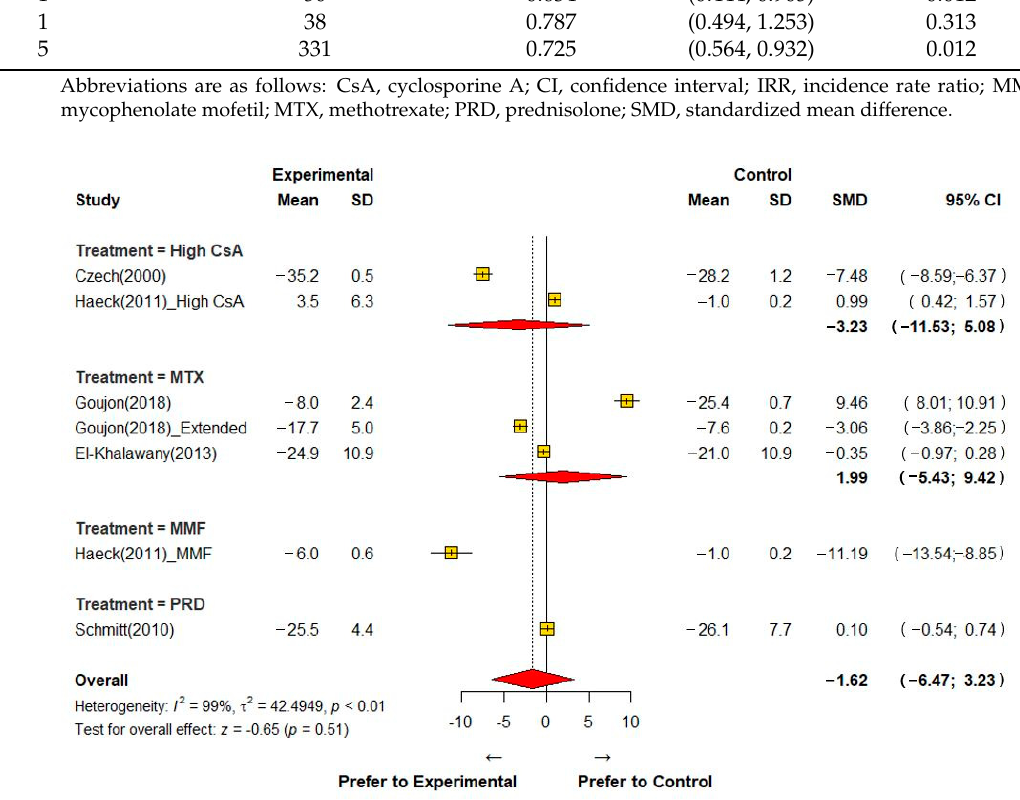
Figure 3. Meta-analysis of the effects on reducing atopic dermatitis symptoms [13–17]. CI; confidence interval, CsA; Cyclosporine A, MMF; mycophenolate mofetil, MTX; methotrexate, PRD; prednisolone, SD; standard deviation, SMD; standard mean difference.